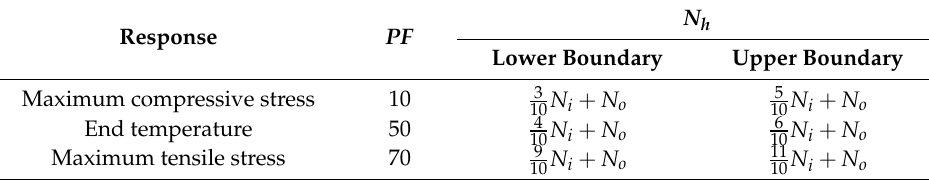
Table 5. Correlation between PF and node numbers in the input and output